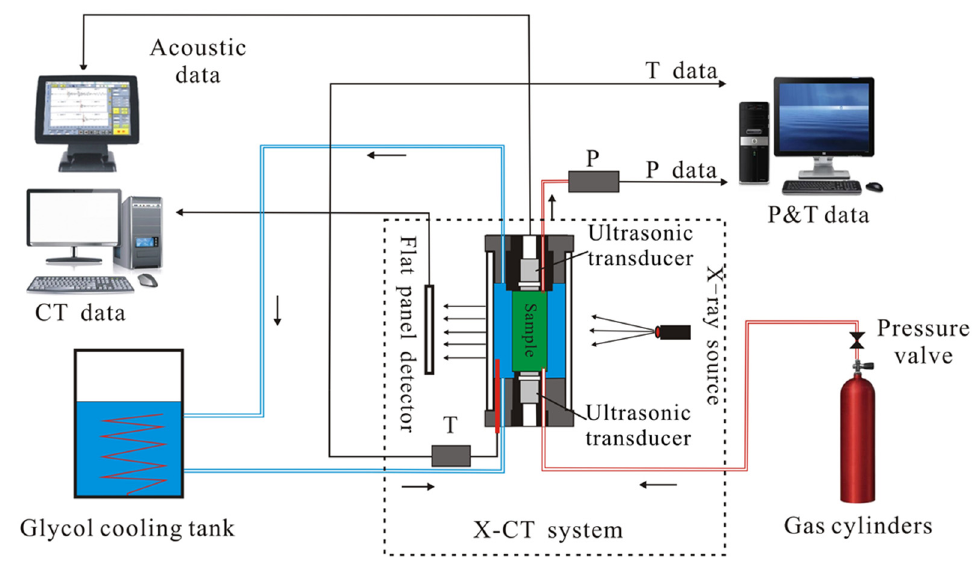
Figure 1. Schematic configuration of the experimental device. T represents Temperature sensor, P represents Pressure sensor.